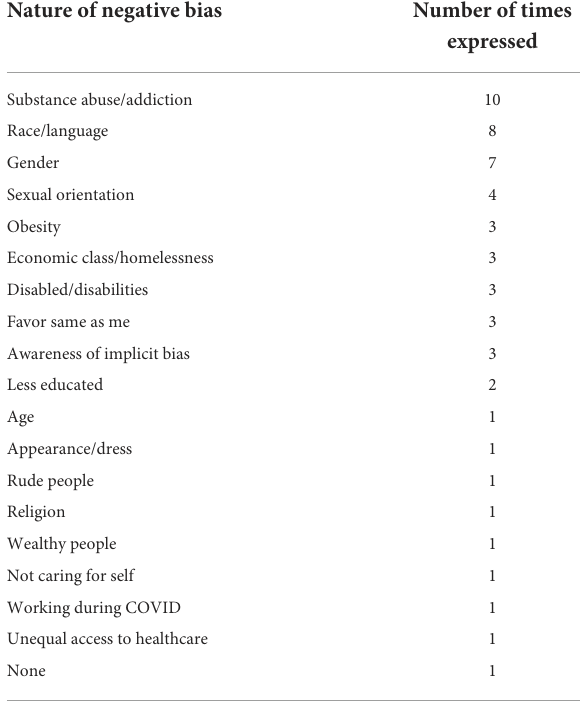
TABLE 2 Summary of written statements of biases expressed by students in the survey about their team- and service-learning experiences (40 of 43 students stated one or more of their biases in response to the question “Of what biases did you become aware during encounters with people/venues in your service-learning project?”).